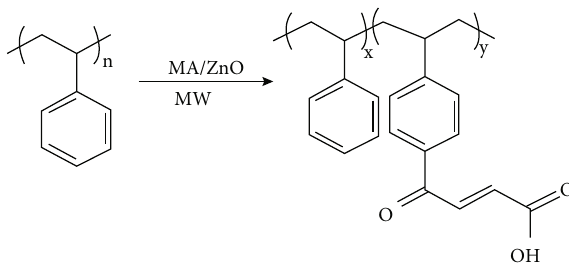
Figure 12: Implementation of the microwave generator in the twin-screw extruder for the ROP of lactide. Figure 13: Grafting maleic anhydride on